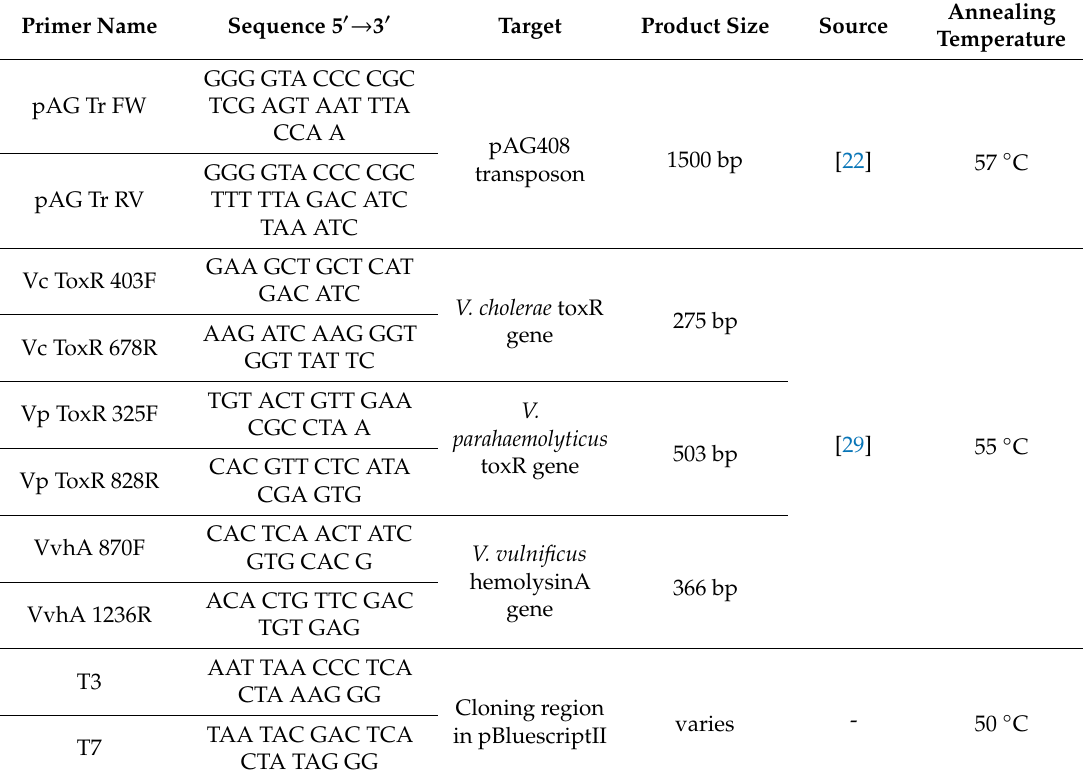
Table 3. PCR primers and annealing temperatures used in this study. All PCR amplification reactions utilized DNA Taq Polymerase and dNTPs provided by NEB via the manufacturer’s instructions. The Vibrio species-specific primers were used in a multiplex